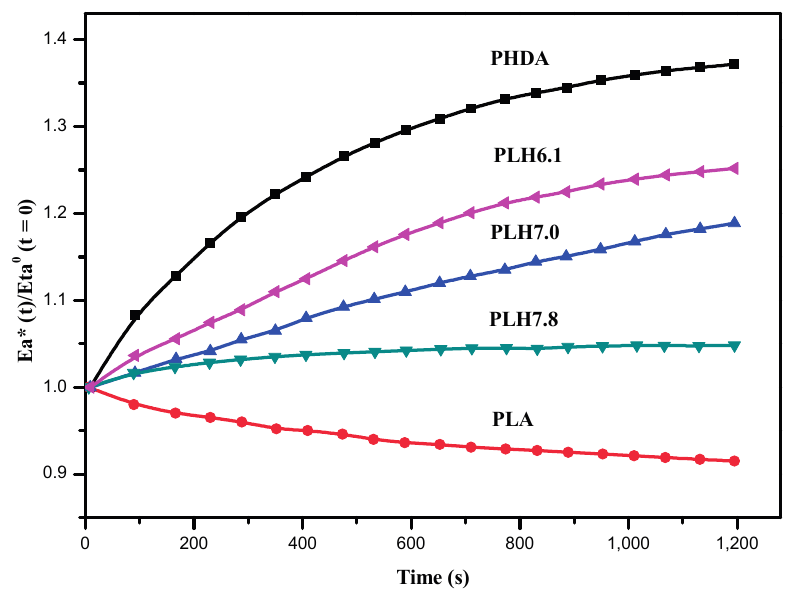
Figure 4. Eta * ( t )/Eta 0 ( t = 0) evolution versus time for the PLH copolymers at 180